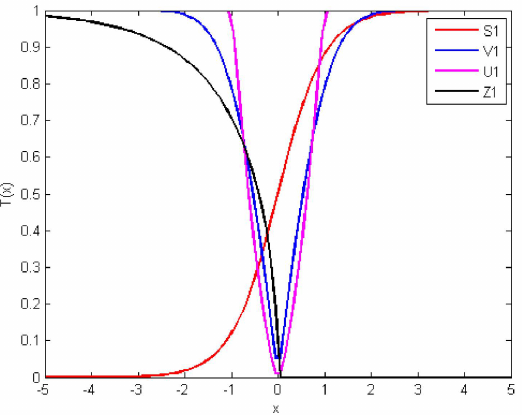
Figure 5. The curve of S1(x), V1(x), U1(x), and Z1(x) transfer